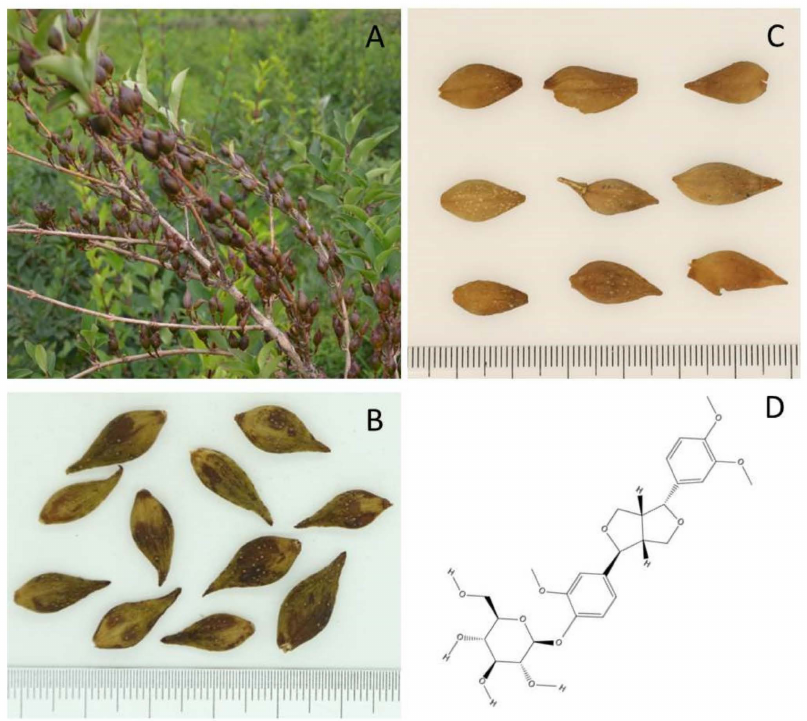
Figure 1. F. suspensa and phillyrin. ( A ) Fruits of F. suspensa grown in Lingchuan County, Shanxi Province, China; ( B ) Qing qiao; ( C ) Lao qiao; ( D ) Structure of phillyrin (created with ChemDraw 19.0).